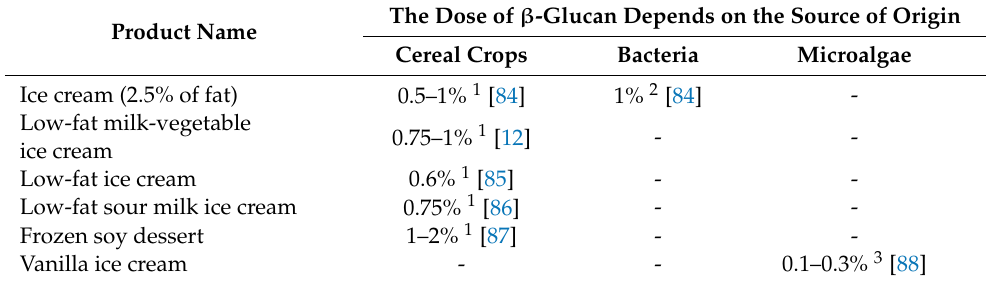
Table 4. Recommended doses of β -glucan of various origins in ice cream and frozen